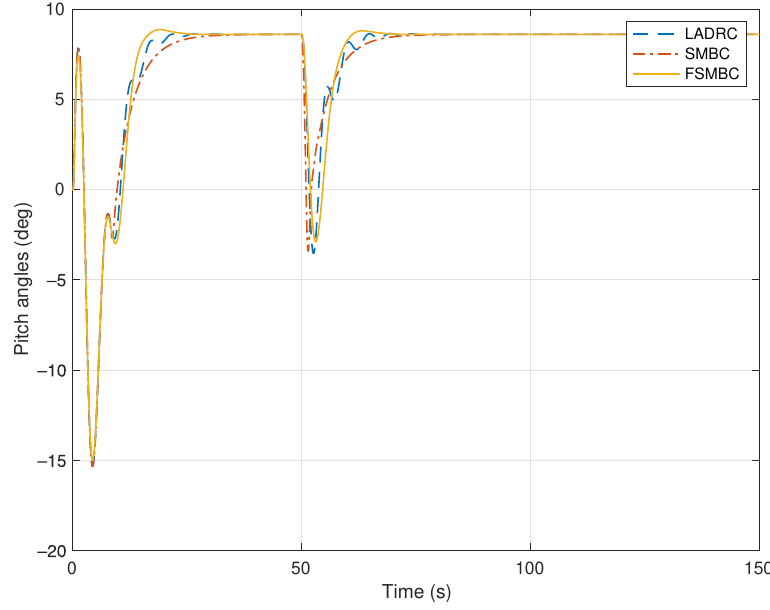
Figure 9. Simulation results of the pitch angle for variable altitude control.